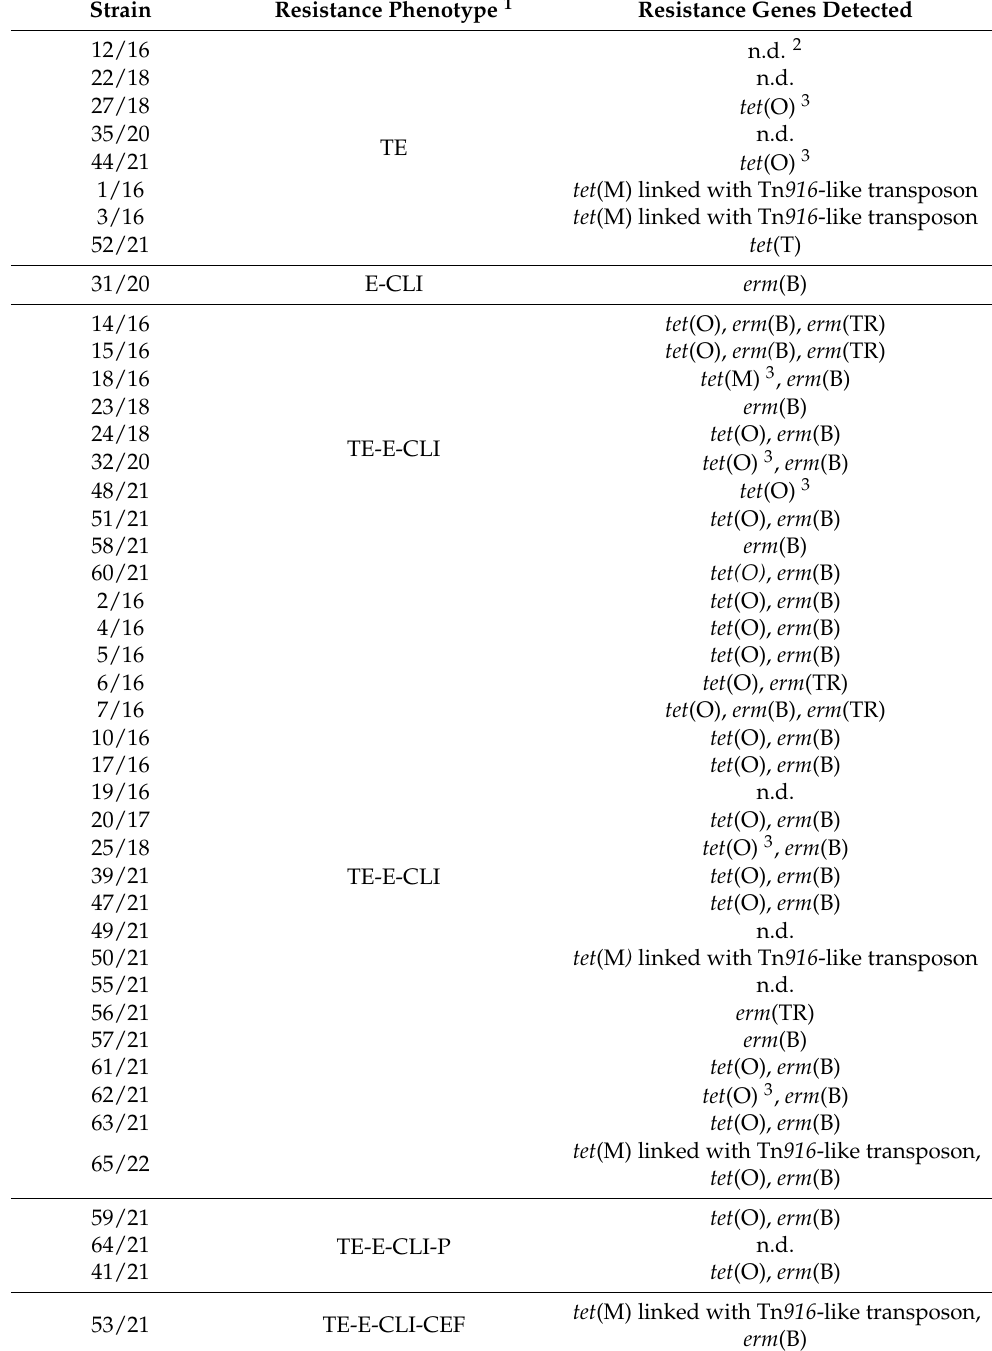
Table 2. The consistency between the resistance phenotype and genotype among studied S. canis strains ( n =